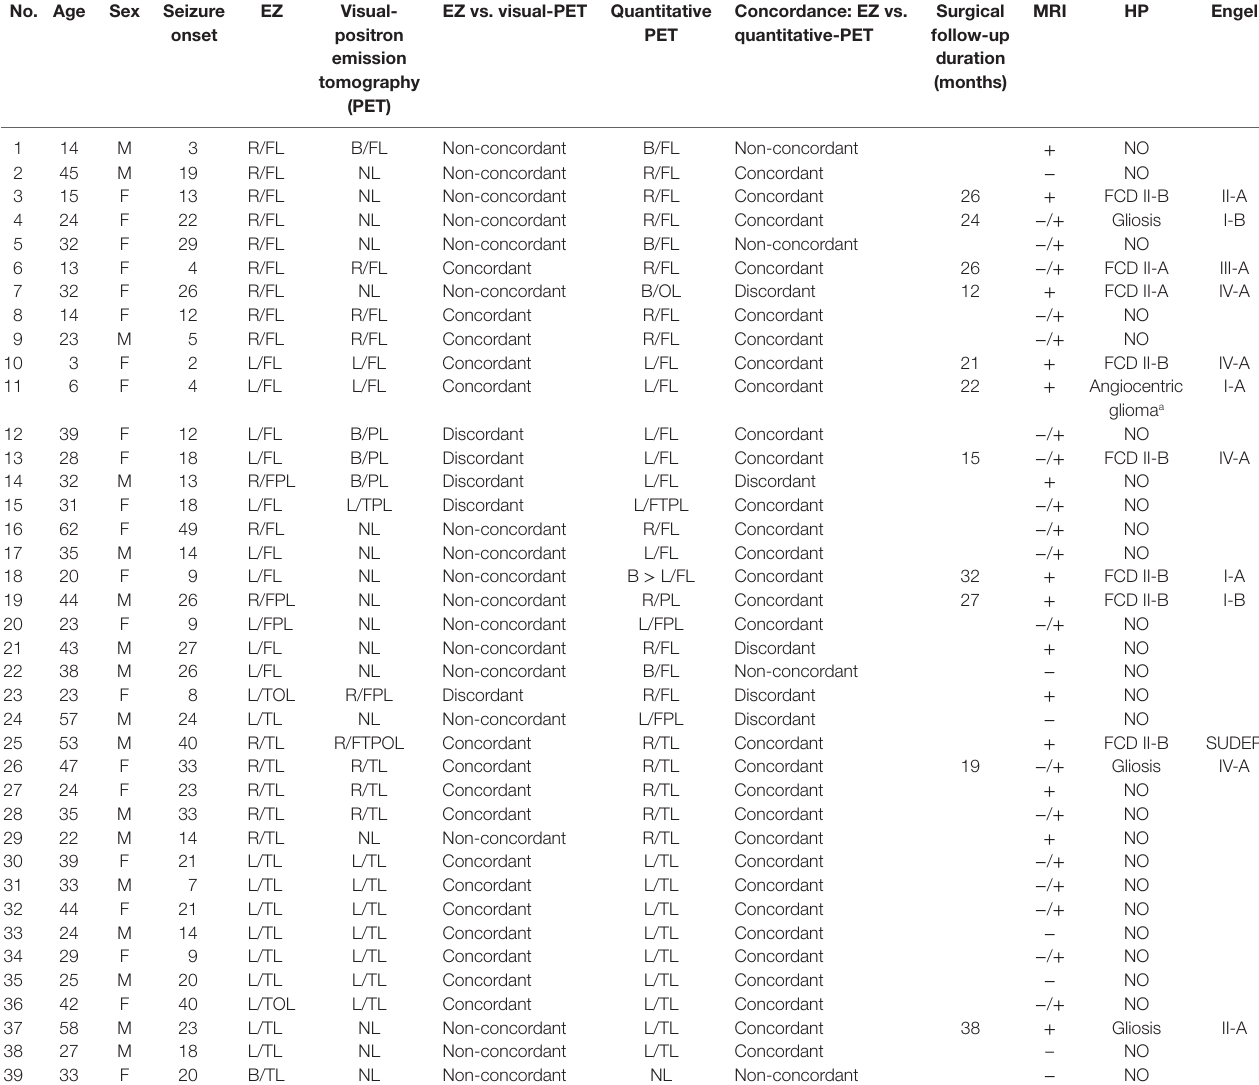
TaBle 1 | Demographic and clinical patient